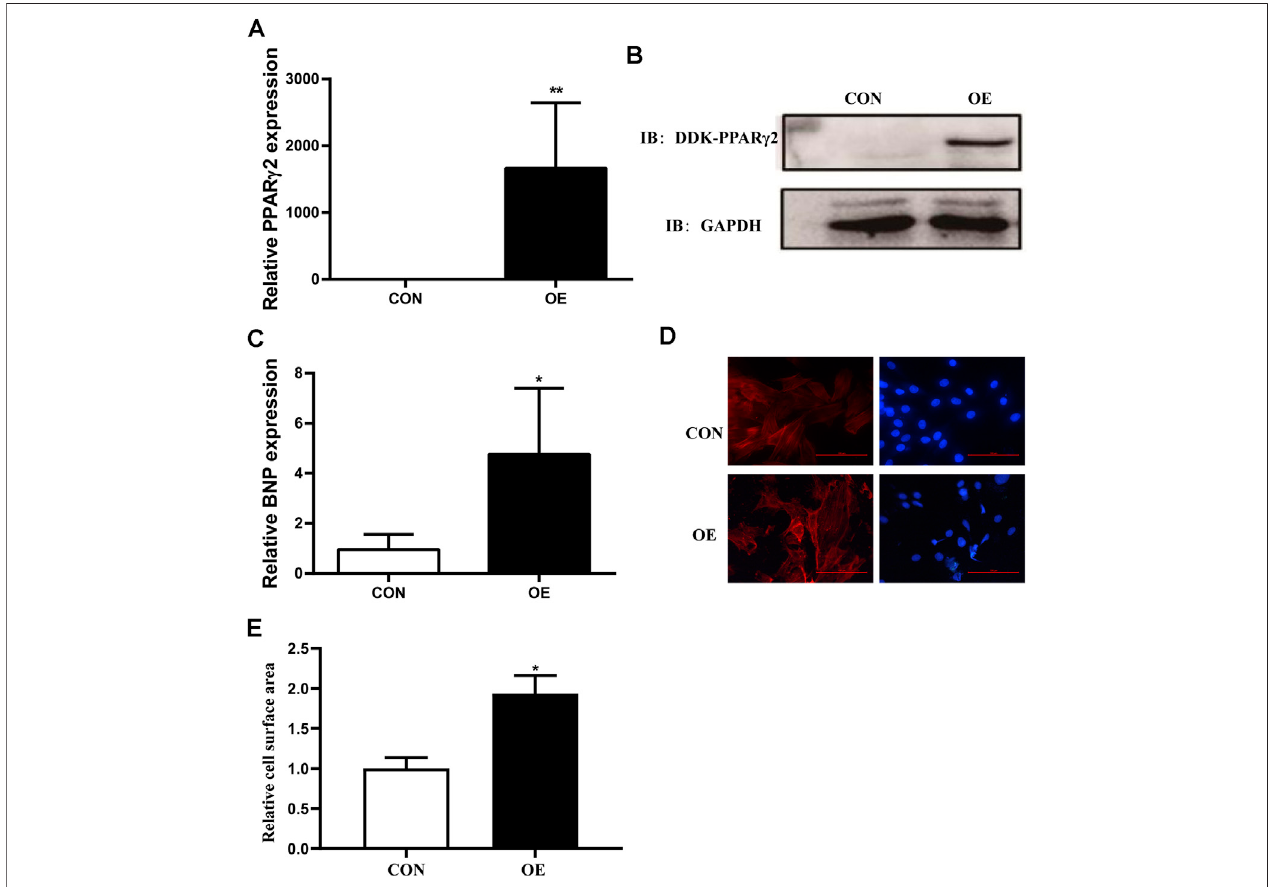
FIGURE 2 | Overexpression of PPAR γ 2 is suf fi cient to lead to hypertrophy in cardiac myocytes. (A) Measurement of PPAR γ 2 mRNA levels in cardiomyocytes. (B) Analysis of protein levels with Western blot after overexpressing DDK-PPAR γ 2 in cardiomyocytes. (C) mRNA levels of the hypertrophic marker gene BNP after overexpressingPPAR γ 2incardiomyocytes. (D) representativeimagesof α -SMAstainingwithCY3(red)andnucleiwithDAPI(blue)incardiomyocytes. (E) quanti fi edcell surface areas in cardiomyocytes. CON represents transfection of empty PCMV6 plasmid; OE represents transfection of the PCMV6-PPAR γ 2 plasmid. Means ± SEM for three independent experiments, * p < 0.05, ** p < 0.01 vs. CON.